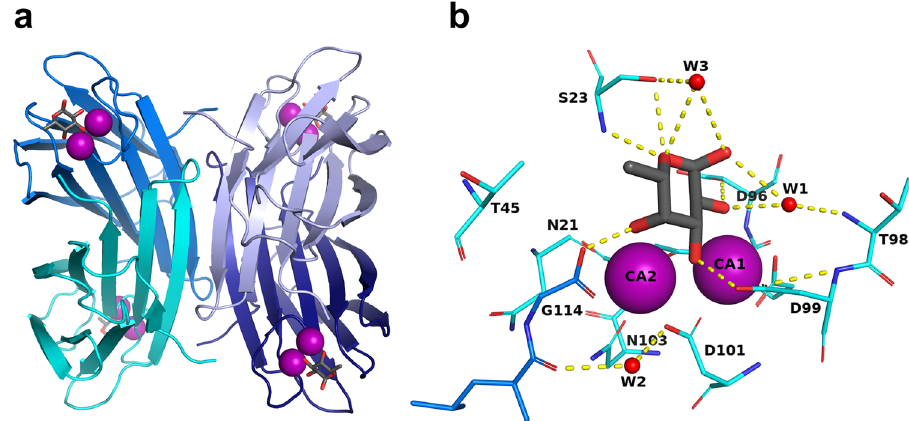
Fig. 1 Structure of LecB lectin in complex with fucose. a Tetramer of LecB (PDB code: 1GZT). b Fucose-binding site. Calcium ions and water molecules are represented by purple and red spheres respectively. Hydrogen bonds are shown as yellow dashed